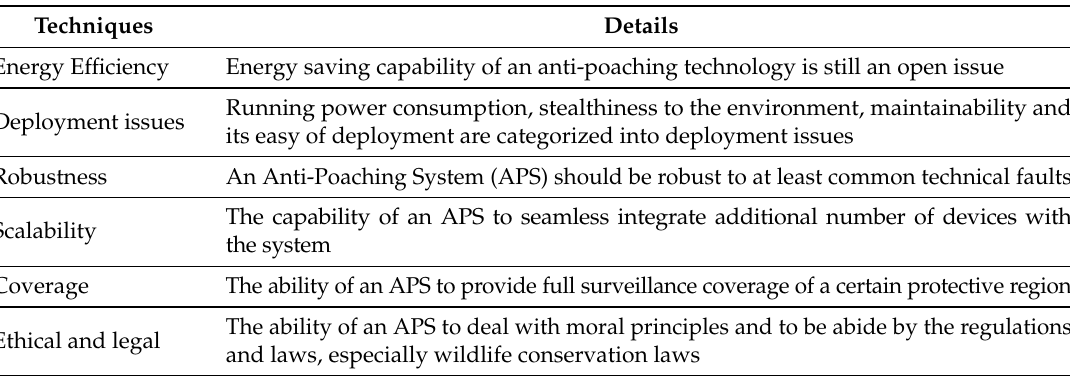
Table 1. Summary of